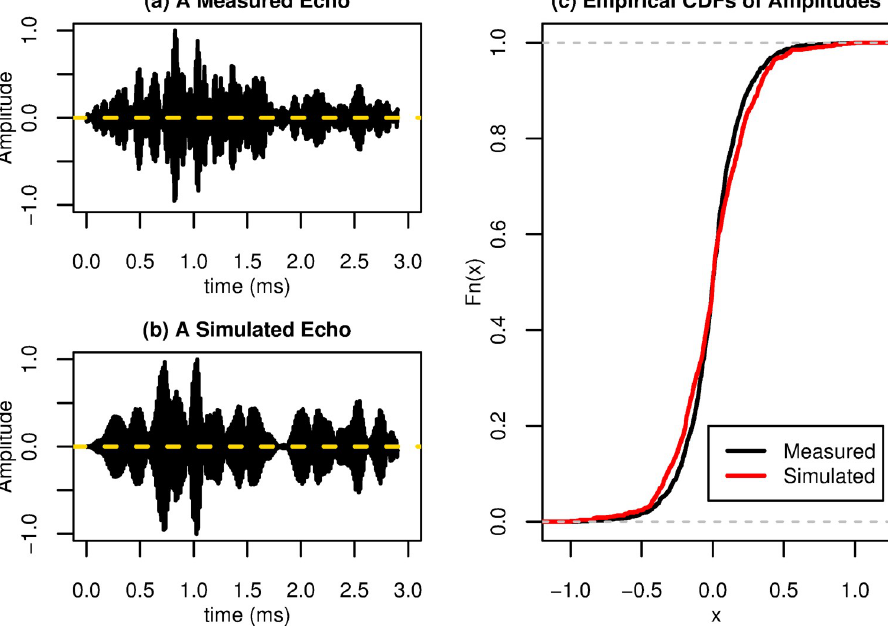
Fig 4. A comparison between simulated and measured echoes for a maple tree. (a) An echo signal measured from a maple tree. (b) An simulated echo signal obtained by matching the simulation setup with the experimental setup. (c) Plots of the empirical CDFs of the signal